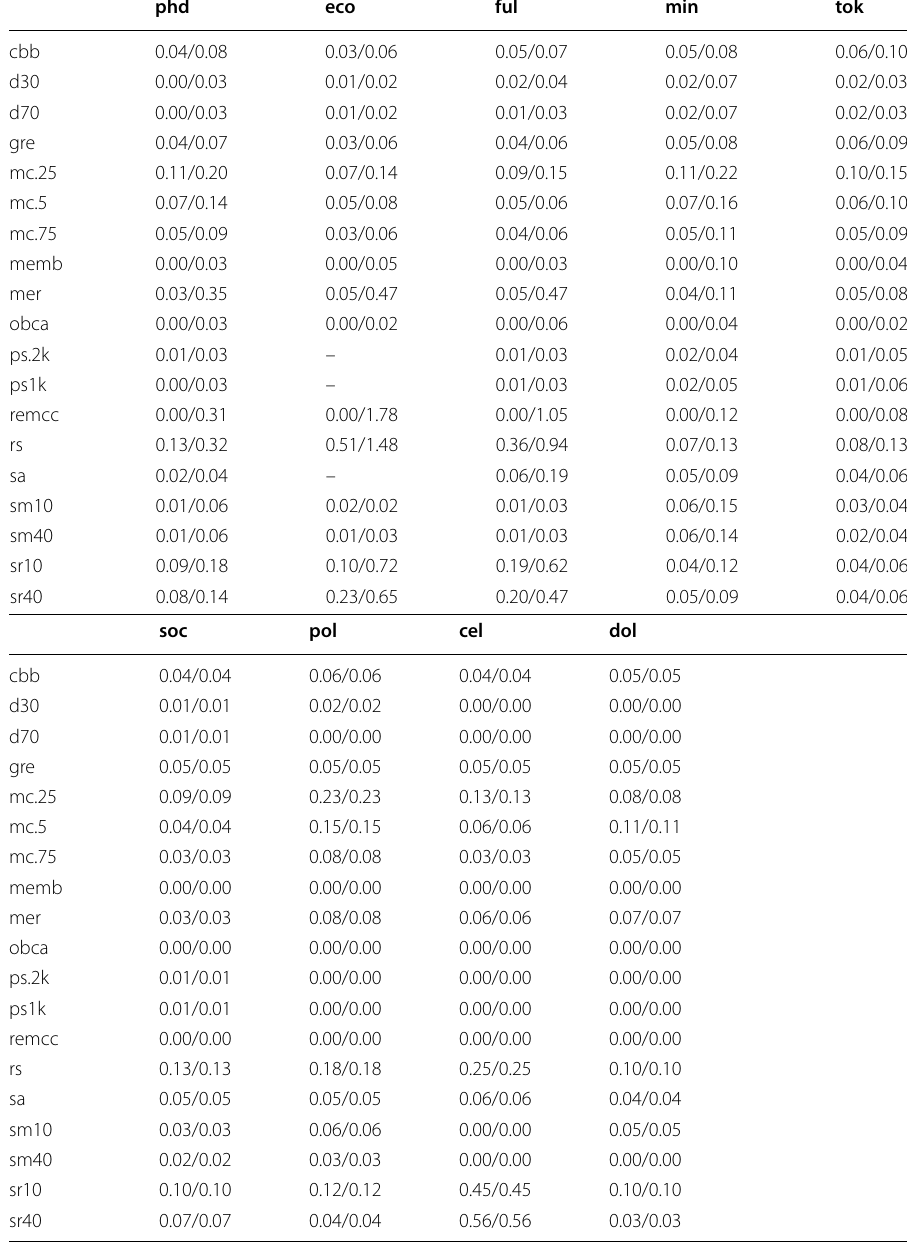
Table 5 Variance in the P performance score: mean intrinsic/total standard